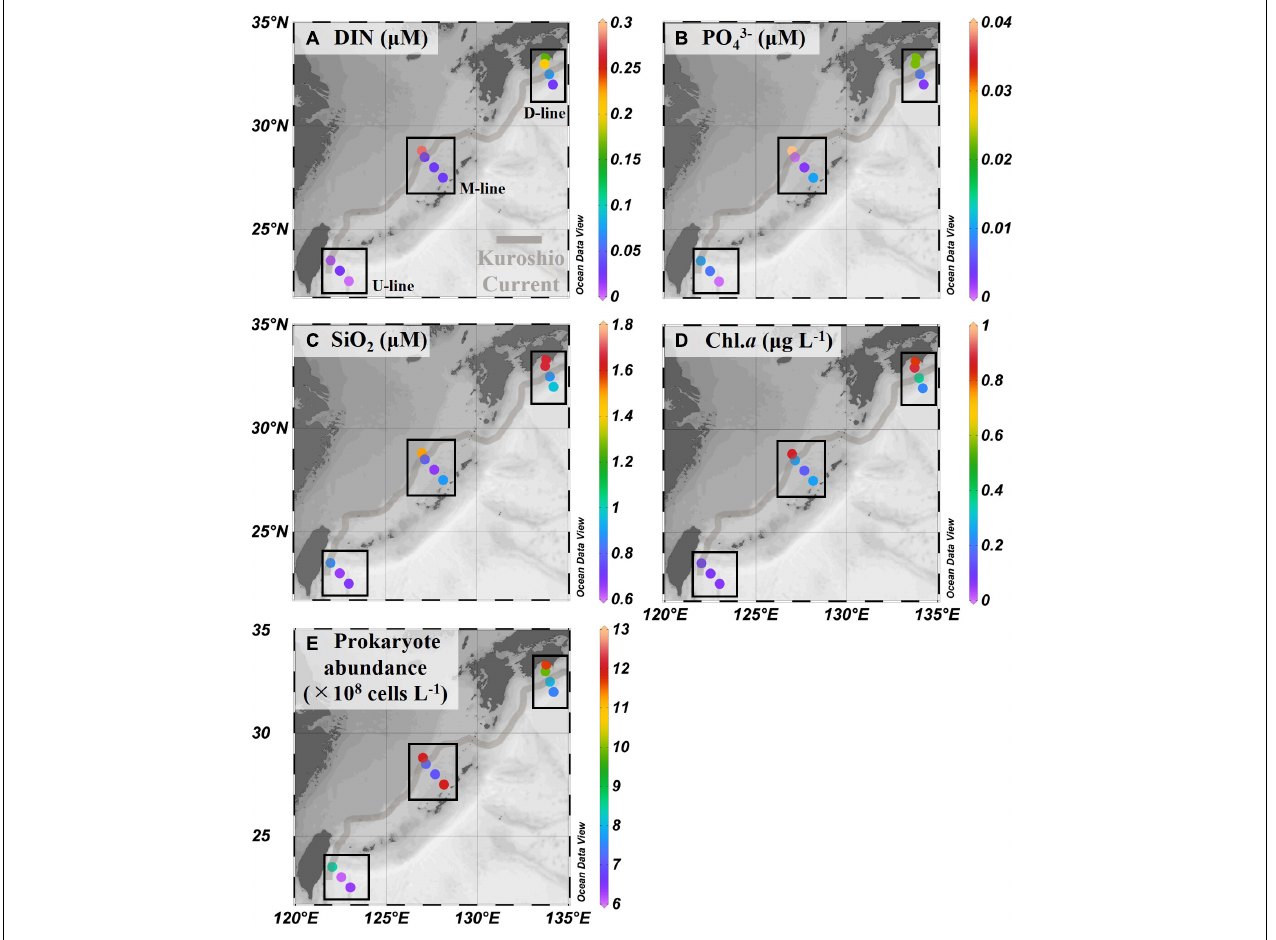
FIGURE 3 | Chemical and biological variables in the Kuroshio region observed during the KH-15-4 cruise. (A–C) Nutrient [DIN: dissolved inorganic nitrogen, PO 43 − and Si(OH) 4 ] concentrations, (D) chlorophyll a (Chl. a ) concentration, (E) prokaryote abundance. Data are shown as in Figure 2 and values are also shown in Table 2 .